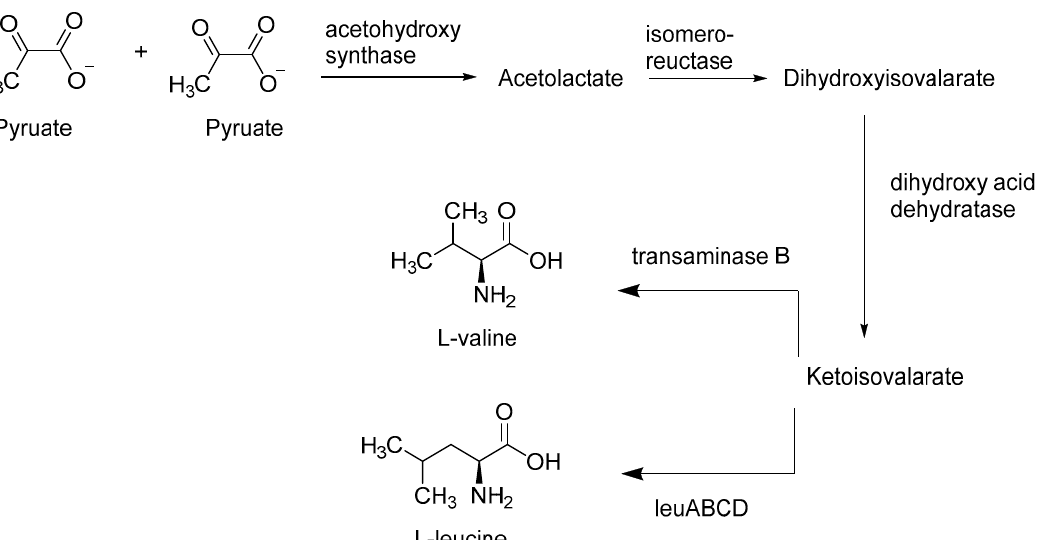
Figure 5. Schematic representation of l -lysine biosynthesis via α -aminoadipate pathway. It illustrates that precursors acetyl-CoA and α -ketoglutarate in the presence of homocitrate synthase form homocitrate (a tricarboxylic acid).